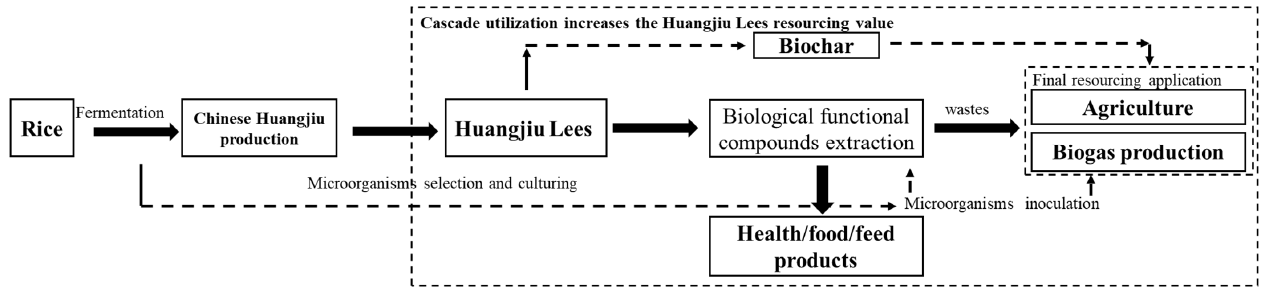
Figure 3. Flow for Huangjiu lees cascade utilization.